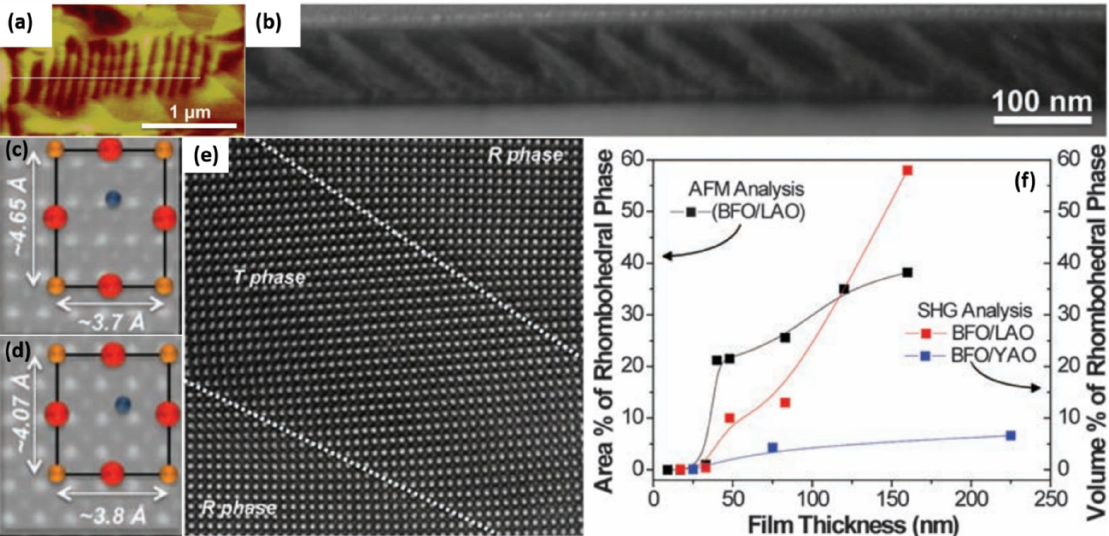
Figure 4. Nanoscale phase coexistence in BFO thin film at strain-driven phase boundary. ( a ) AFM image of nanodomains. ( b ) Low-magnification cross-section TEM image of nanodomains of BFO film. ( c , d ) Enlarged STEM HAADF images with schematic illustration of the unit cells for T phase and the R phase. ( e ) Atomically-resolved STEM HAADF of the boundaries between R and T regions. ( f ) The volume fraction of the R phase with thickness. Reproduced from Ref. [141]. Copyright 2009 American Association for the Advancement of Science.